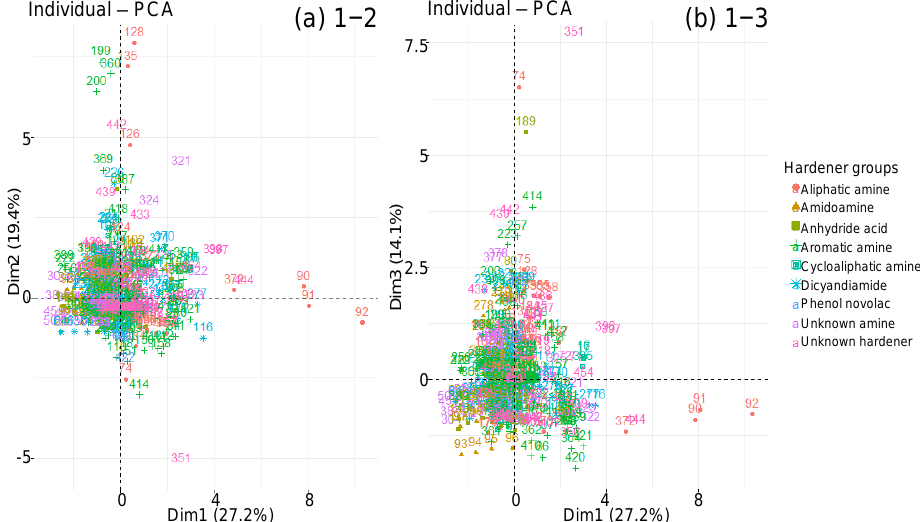
Figure 11. Graphs of individuals on planes ( a ) 1–2 and ( b ) 1–3 of the global PCA, according to hardener